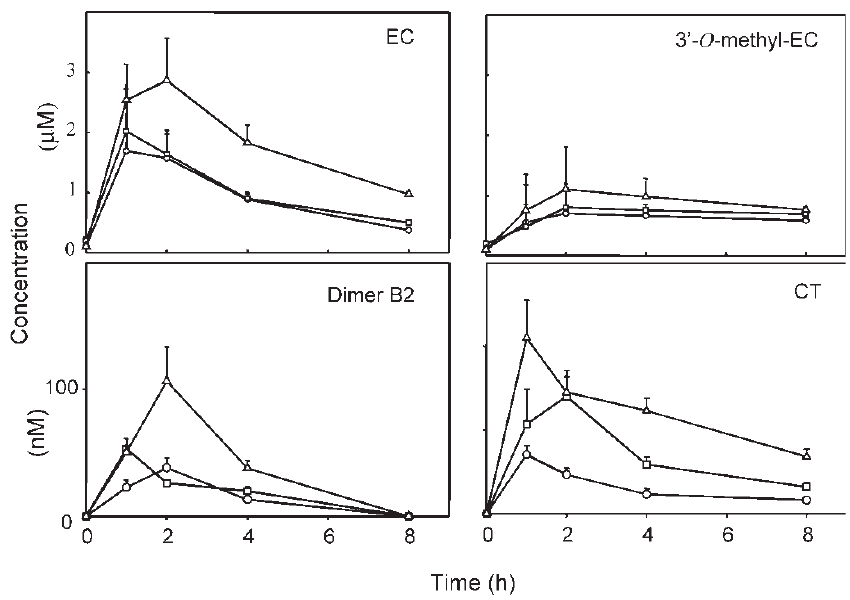
Figure 4. Changes in plasma concentrations of (-)-epicatechin (EC), ( þ )-catechin (CT), 3 0 - O -methyl epicatechin and (-)-epicatechin- (4 b . 8)-epicatechin (Dimer B2) in human subjects after they consumed low-dose (0.25g/kg BW, W - W ), medium dose (0.375g/kg BW, A - A ), and high dose (0.50g/kg BW, D - D ) flavonoid-rich cocoa beverage. Data are expressed as means ^ SEM of n ¼